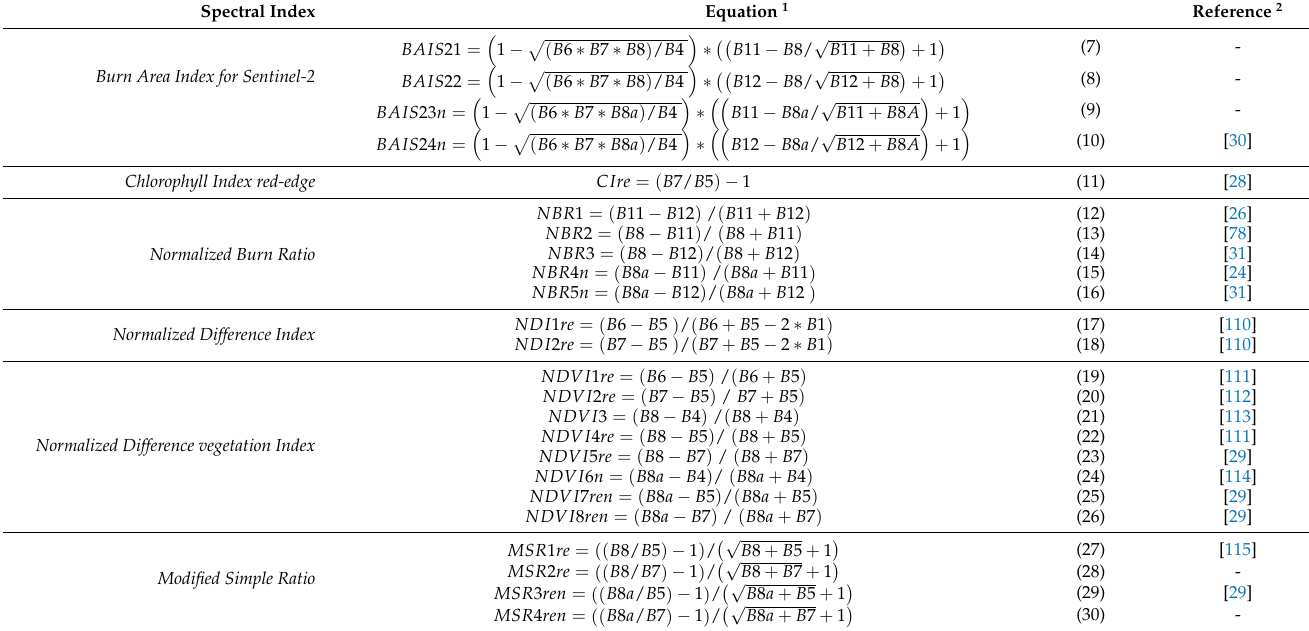
Table 3. Spectral indices derived from Sentinel L1C and L2A imagery calculated in this